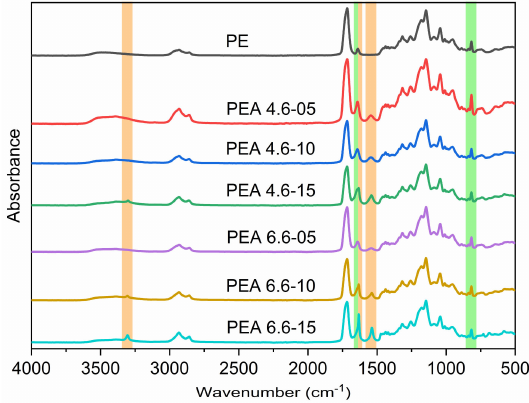
Figure 1. FTIR spectra of synthesized resins. C–C double bond vibrations are highlighted in green, vibrations derived from the amide group are in